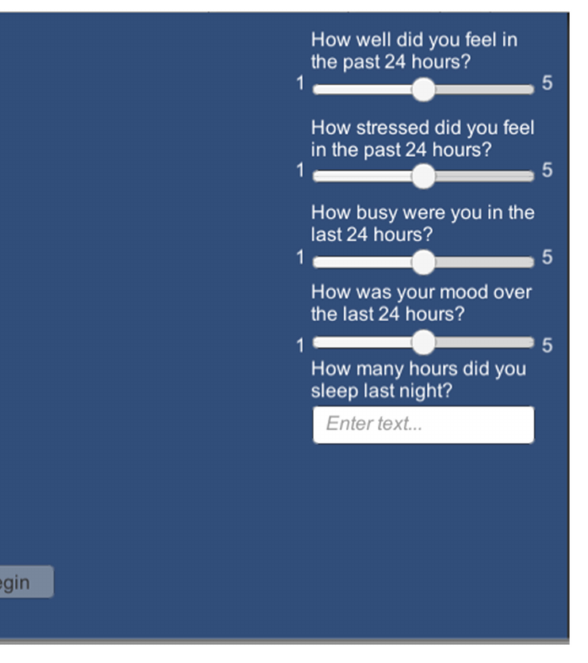
FIGURE3 Screenshot of the Daily Survey Screen that appears just after the log-in screen in the